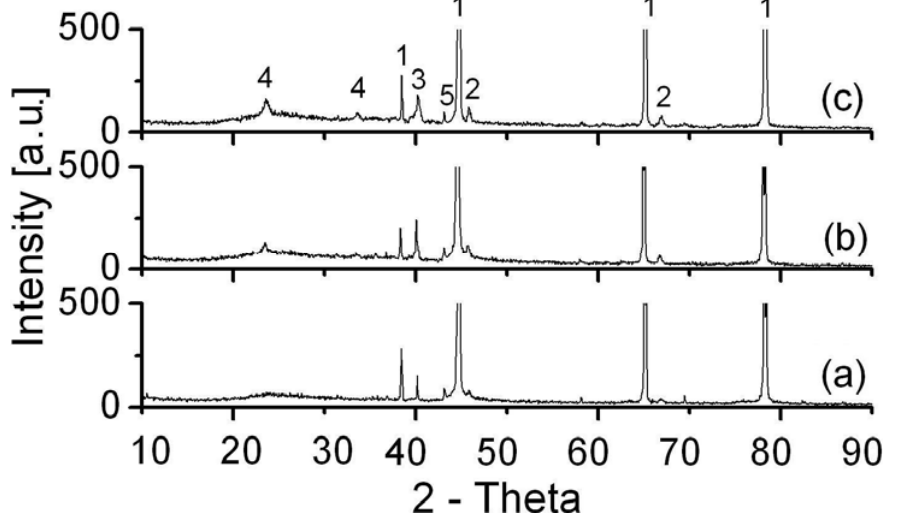
Figure 7. XRD spectra of microarc oxidation coating formed in different treatment period: (a) 5 min; (b) 15 min; (c) 30min. Designation of reflections: Al-(1), γ -Al WO -(4), α -Al O -(5). 3 2 3